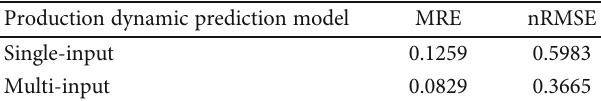
Table 3: MRE and nRMSE error